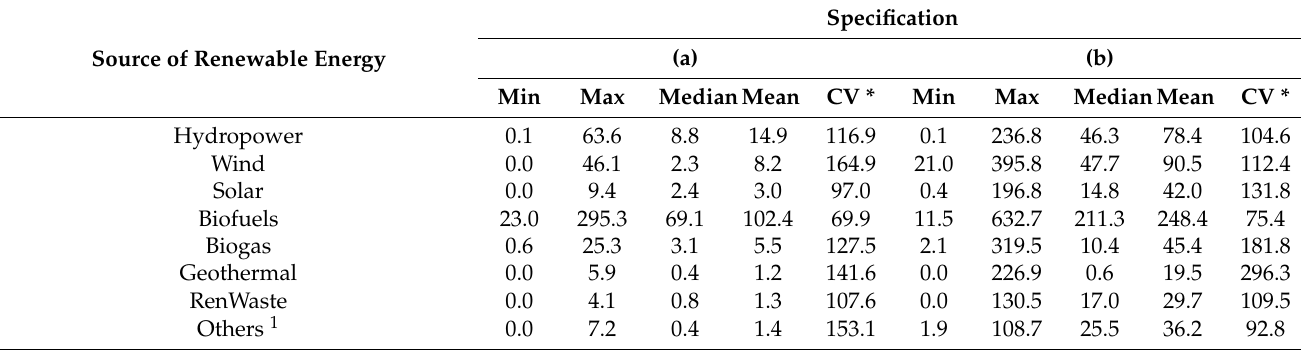
Table 4. Numerical characteristics of renewable energy production by source in EU country groups 2019 (PJ). Others Source of Renew- able Energy Min Hydropower Wind